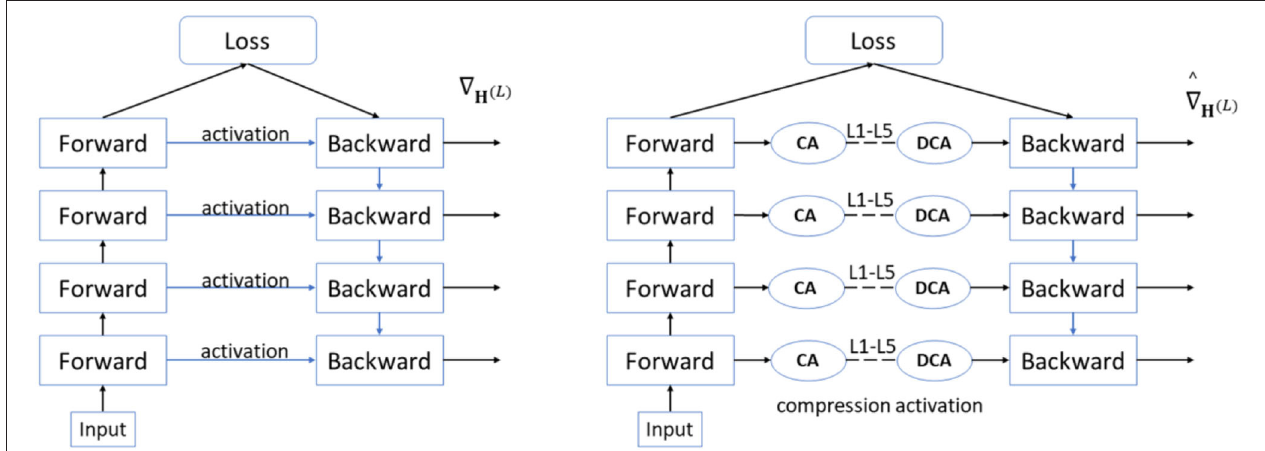
FIGURE 5 | ActNN compression and decompression